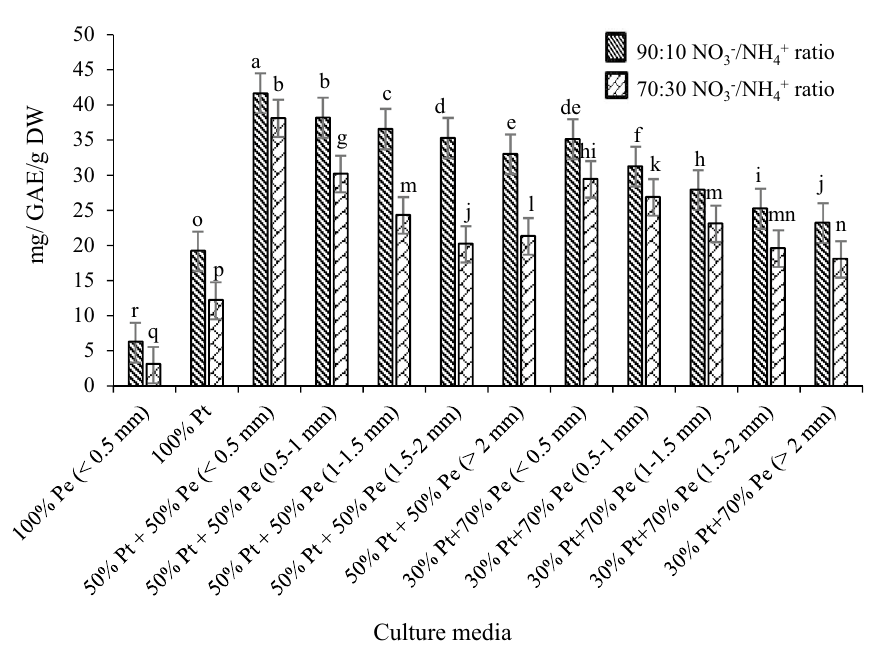
Figure 3. Total phenolic of E.purpurea root at different culture media and NO 3− /NH 4+